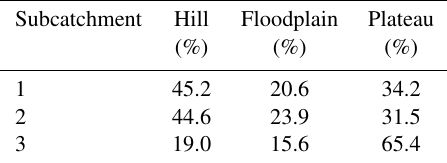
Table 3. Area percentages of topography-based